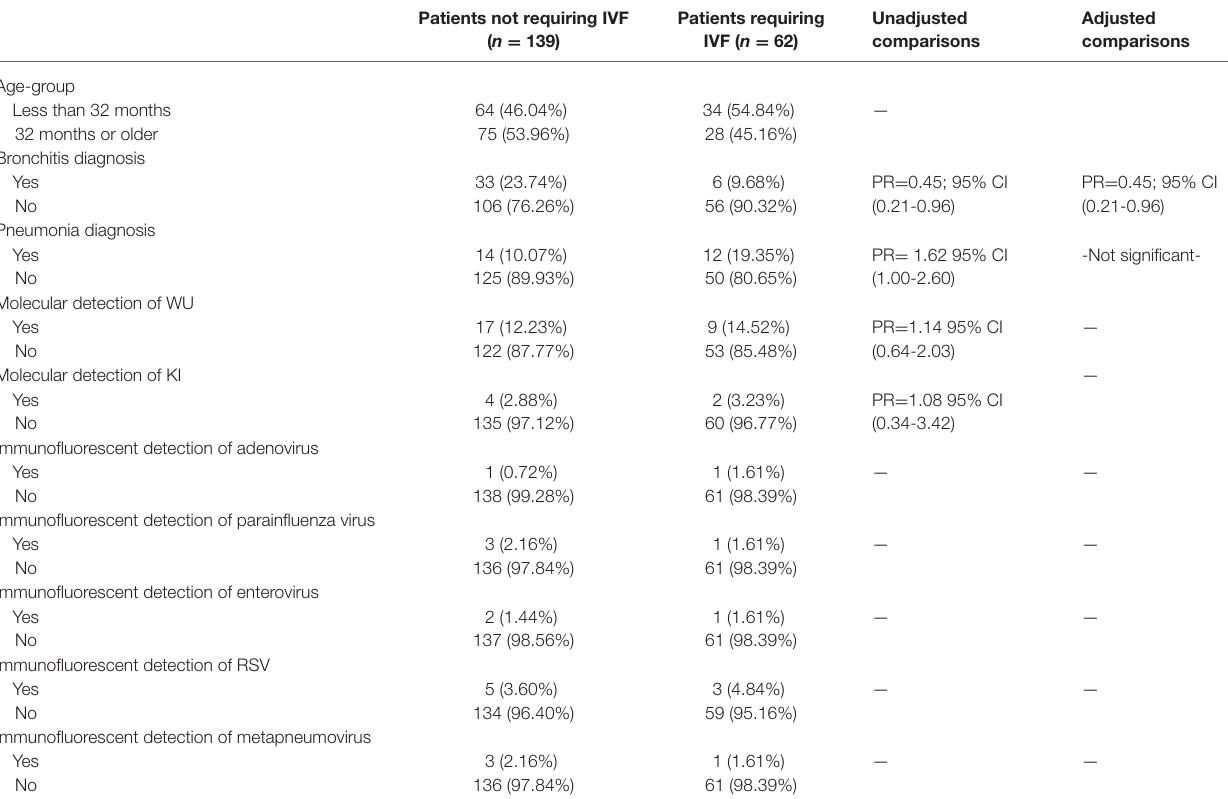
TABLE 3 | Characteristics of 201 pediatric study subjects and an examination of their risk factors for the use of intravenous fluids (IVF), Singapore December 2016 to April 2017.